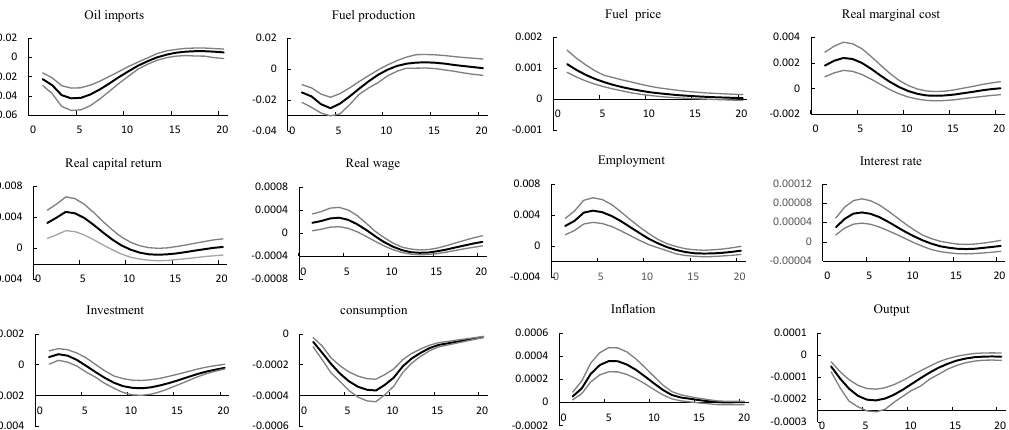
Figure 6. Positive Oil-specific demand shocks. (Note: The black solid line represents the estimated actual mean responses, and the gray solid lines represent the 5 percent and 95 percent posterior interval).